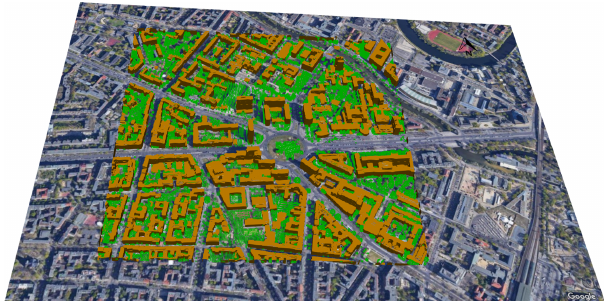
Figure 2. An aerial view of the realistic urban configuration show- ing the 3-D buildings (fitted to the grid) and the plant canopy boxes (trees, shown in green points). The configuration is centred around Ernst-Reuter-Platz in Charlottenburg in Berlin (52 ◦ 30.8 (cid:48) N, 48 ◦ 19.31 (cid:48) E). The copyright for the underlying satellite image is held by © GeoBasis-DE/BKG 2009, Google